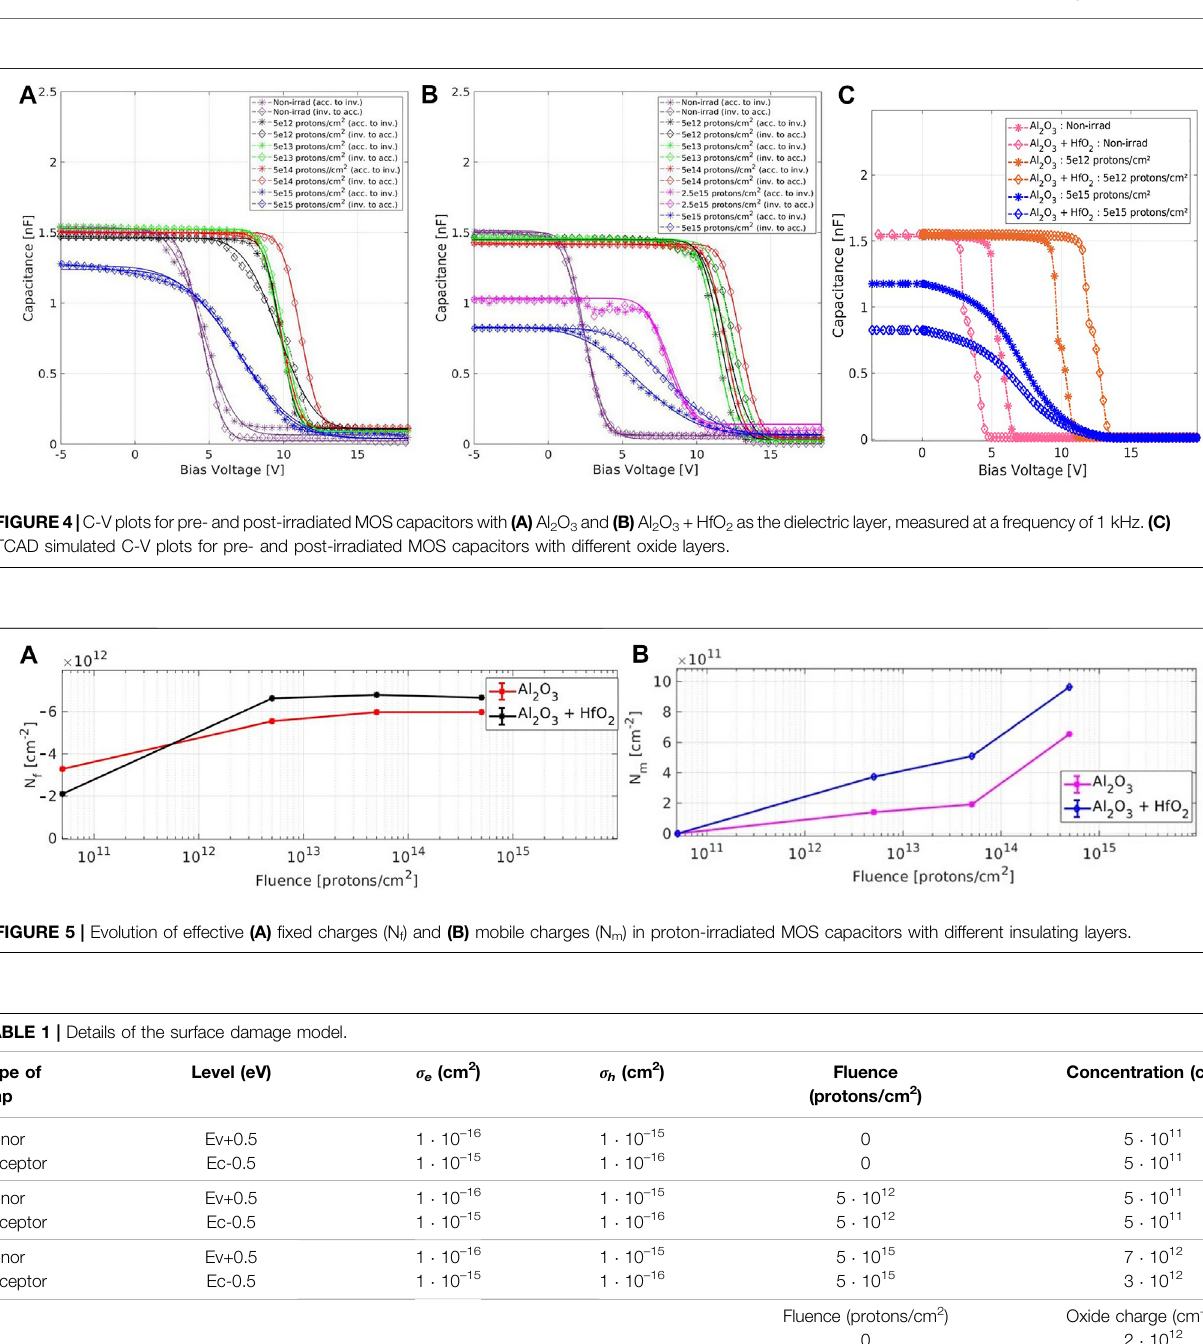
charge with no change in the interface trap concentration.